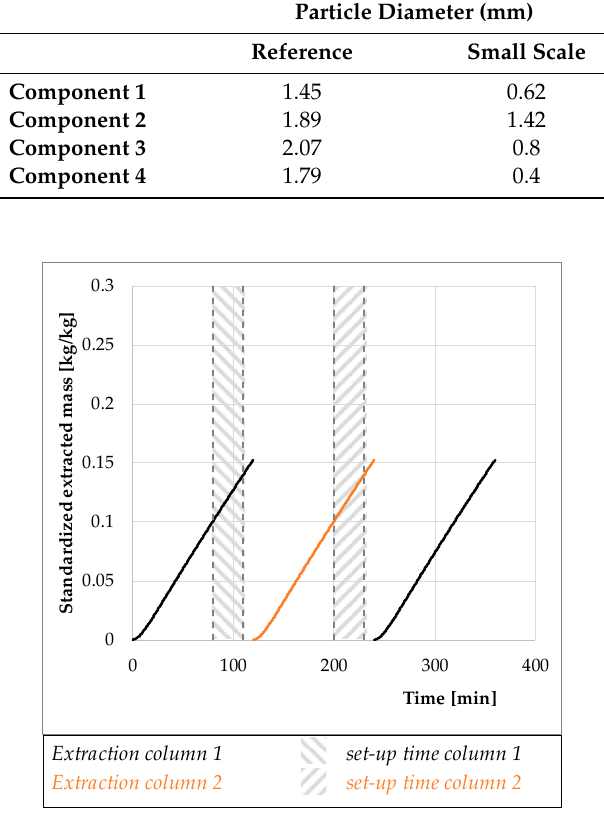
Table 4. Overview of particle sizes in the reference process and the small-scale continuous extraction.